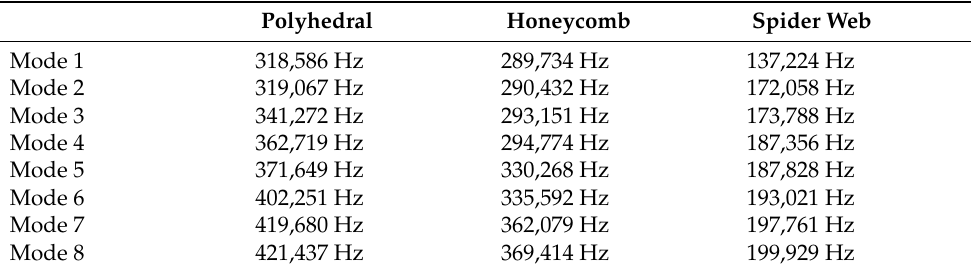
Figure 11. Modal frequencies simulations of polyhedral, snowflake, and spiderweb unit cell. ( a ) polyhedral unit cell: non homogenous top/bottom resonance accumulation, ( b ) snowflake, bipolar resonance accumulation ( c ) spiderweb unit cell: perfect uniform resonance